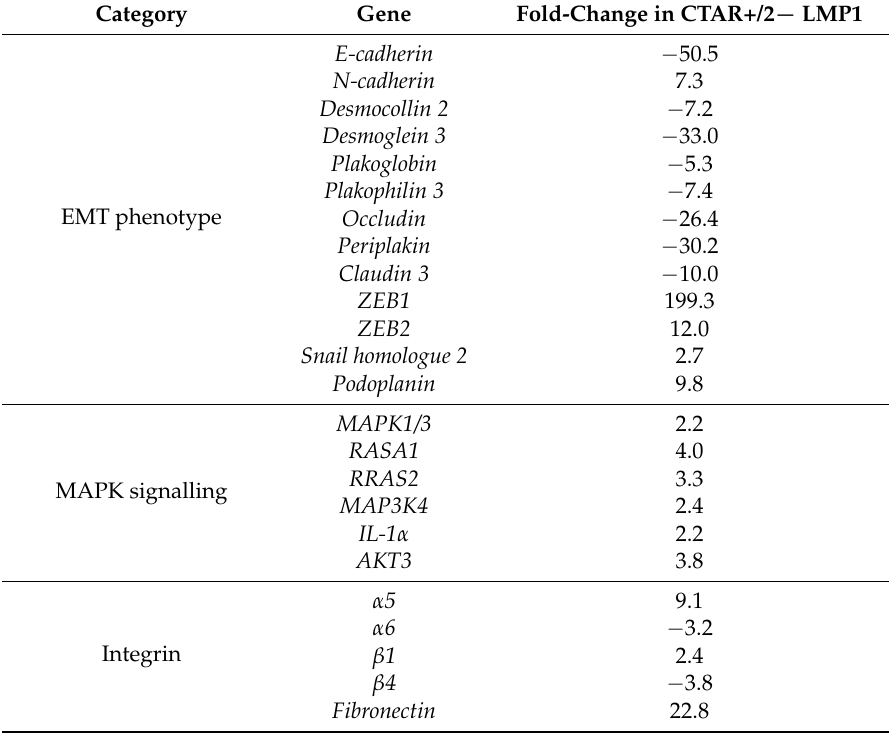
Table 1. Table summarizing the key gene changes mapped to the CTAR1 domain of LMP1 relating to the EMT phenotype, mitogen-activated protein kinase (MAPK) and integrin